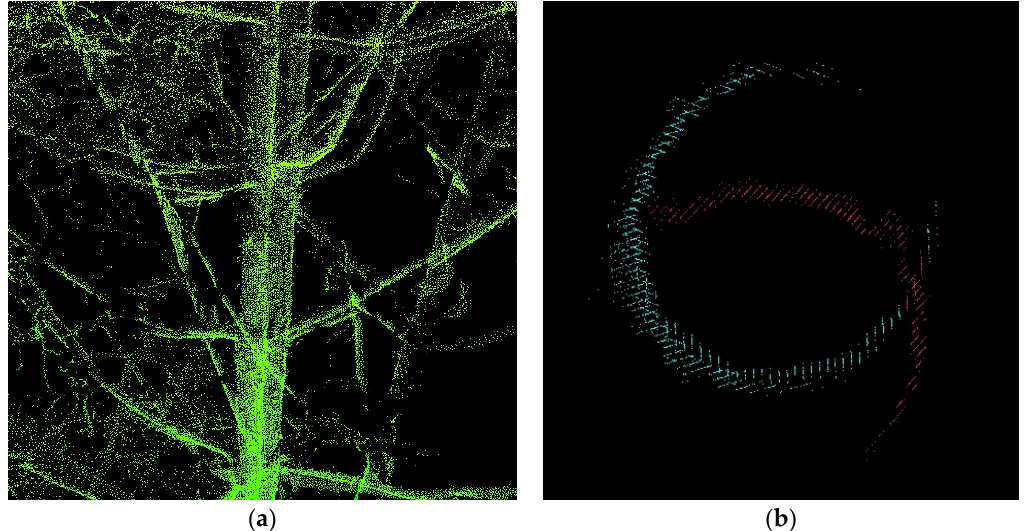
Figure 2. Multi-station stem point cloud after registration. ( a ) Different stations near RH75 of the tree point clouds; ( b )